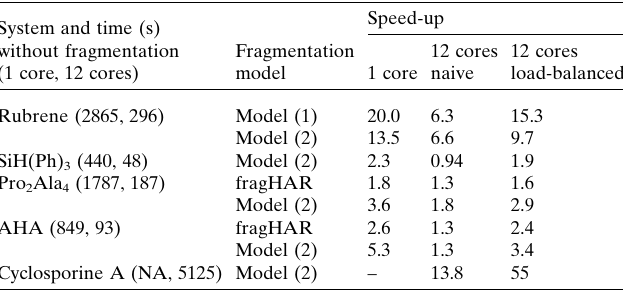
Table 2 Wavefunction calculation time and speed-up related to fragmentation for selected systems.